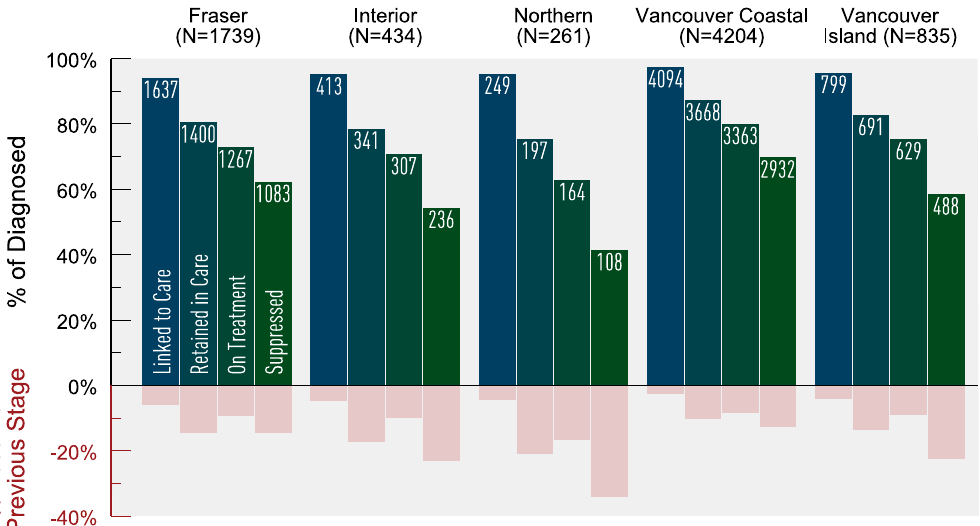
Fig. 7. Estimated HIV cascade of care by Regional Health Authority in 2011 for British Columbia. *There were 148 HIV-diagnosed individuals with missing Regional Health Authority information. Of these, 106 were linked to care; 51 of those linked to HIV care were retained in care; 24 of those retained in care were on antiretrovirals (ARVs) and 14 of those on ARV were